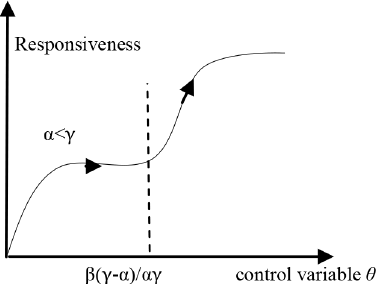
Figure 1. Change figure of system order parameter around threshold parameter when α < 